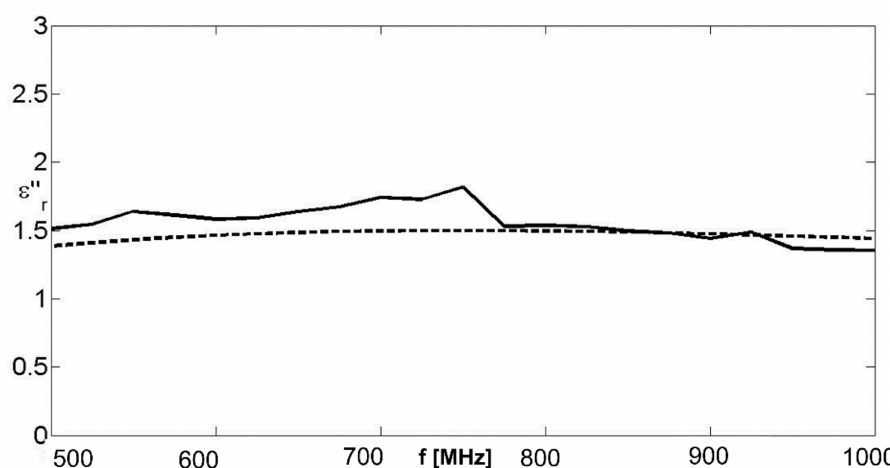
Figure 12. Imaginary part of the equivalent complex permittivity for a Debye dispersion law. Solid line: retrieved value; dashed line: actual value. Noisy data with SNR = 20 dB. Random parametric error on the length of the probe, Gaussian with standard deviation 0.2